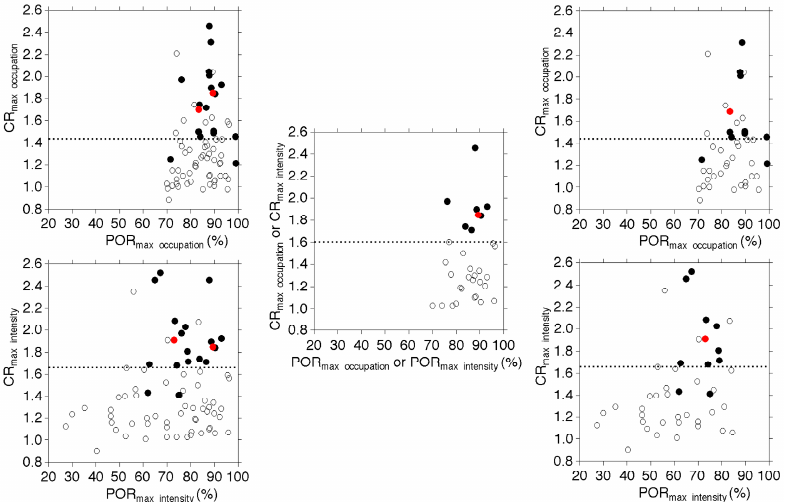
Figure 1. Relationship between the plaque occupation rate (POR) in the image with the maximum POR (POR max occupation ) or that in the image with the maximum plaque intensity (POR max intensity ), contrast ratio (CR) in the image with POR max occupation (CR max occupation ), or that in the image with the maximum plaque intensity (CR max intensity ) and development of microembolic signals (MES) during exposure of the carotid arteries ( left , for all patients; middle , for patients with identification of the image with the POR max occupation and the image with the maximum plaque intensity; right , for patients without this identification). In the middle panel, each POR max occupation or CR max occupation is identical to POR max intensity or CR max intensity , respectively. Closed and open circles indicate patients with and without MES, respectively. Red and black circles indicate patients with and without postoperative new neurological deficits, respectively. Dashed horizontal lines denote the cutoff points closest to the left upper corners of the receiver operating characteristic (ROC) curves in predicting the development of MES.